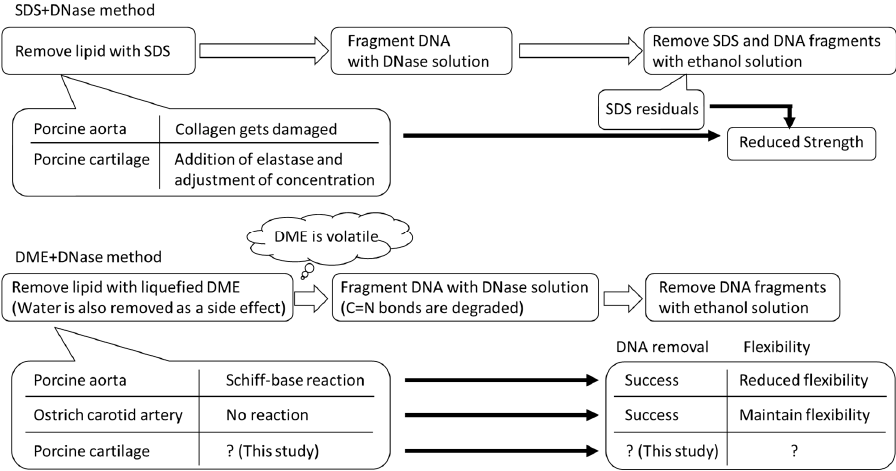
Figure 1. Decellularization procedure of this study using SDS and lique fi ed DME.